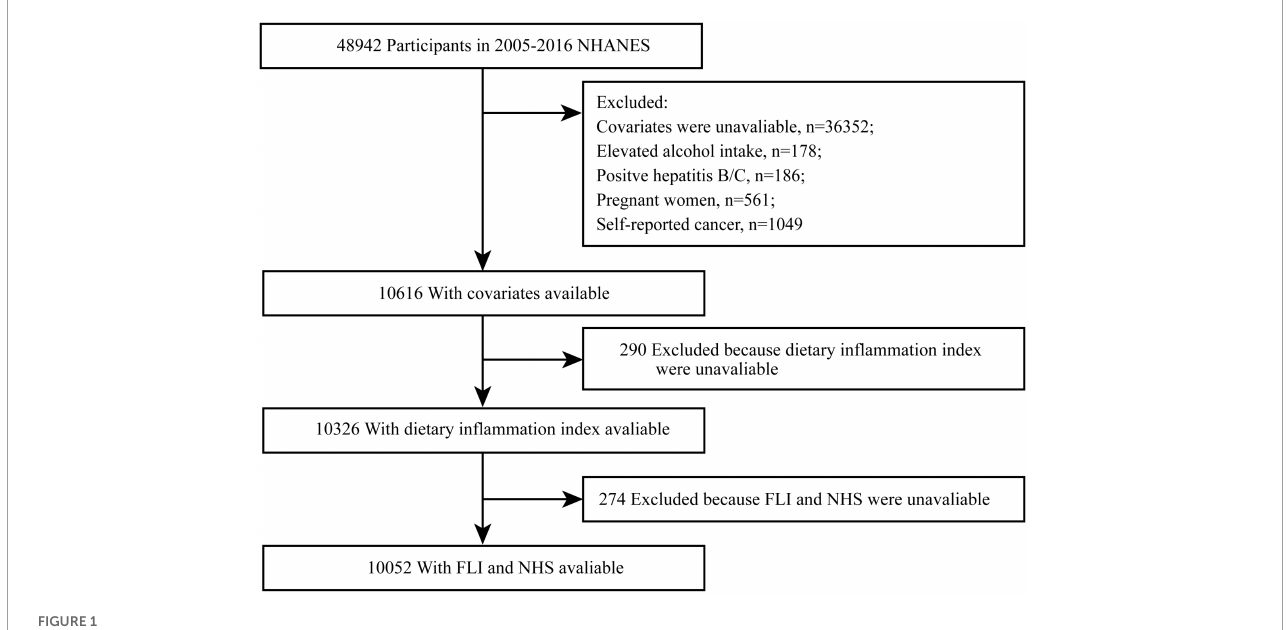
FIGURE1 Participants flow chart.